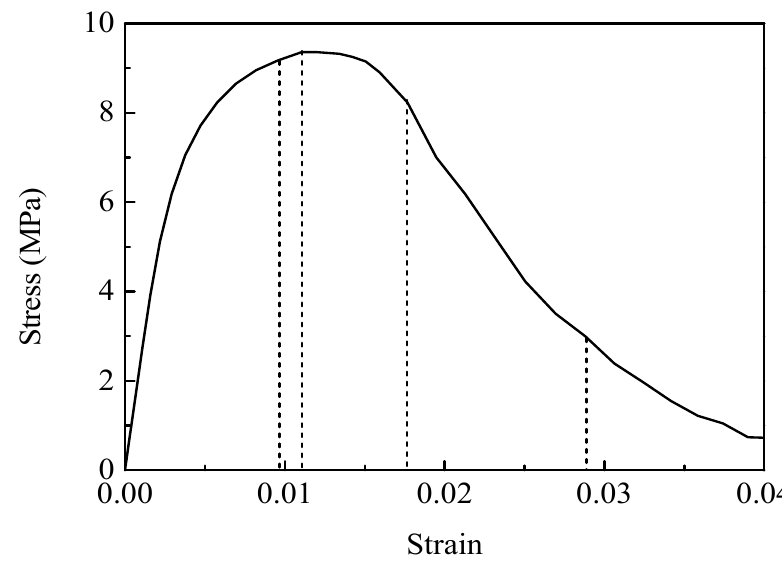
17 of 24 Figure 17. Tensile stress–strain curves of PBX 9501 with different interface strengths at a strain rate of 10 − 3 s − 1 . ( a ) ( c ) Figure 18. Crack path of PBX 9501 under uniaxial tension at a strain rate of 10 − 3 s − 1 for different interface cohesive strengths: ( a ) 1 MPa, ( b ) 1.66 MPa, and ( c ) 3 MPa. 4.2. Simulations of Uniaxial Compression 4.2.1. Mechanical Response and Failure Mechanism The mechanical behavior of PBX 9501 under uniaxial compression is obviously different from that under uniaxial tension. Figure 19 plots the stress–strain response of PBX 9501 at a compressive strain rate of 10 − 3 s − 1 . The similar response features with those under uniaxial tension (such as initial rapid growth, peak stress, and softening behaviors) can also be observed. While some notable differences still exist, as shown in Figure 20, the softening rate of PBX 9501 under uniaxial compression is lower than that under uniaxial tension. The peak strength and failure strain are